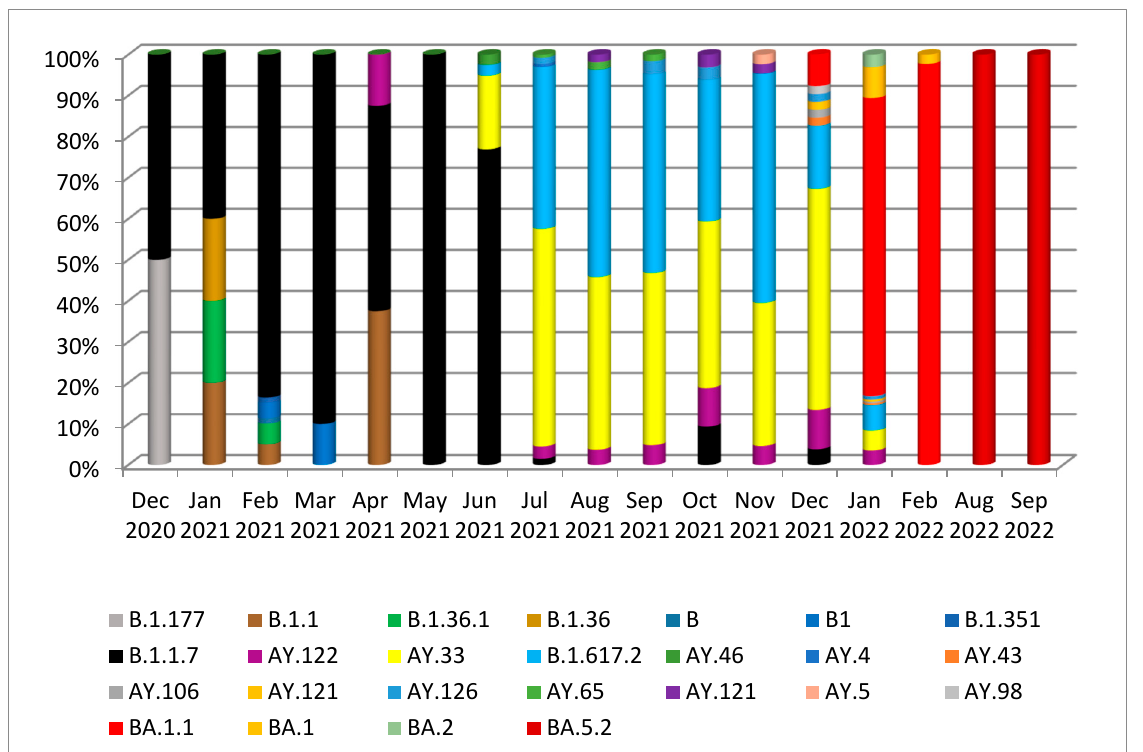
Figure 2. Circulation of SARS-CoV-2 clades (variants) in Iraq during five pandemic waves using the Nextclade system.